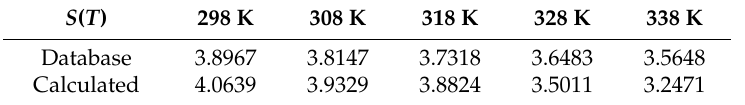
Table 2. Line intensity (10 − 4 cm − 2 · atm − 1 ) values from database and calculated